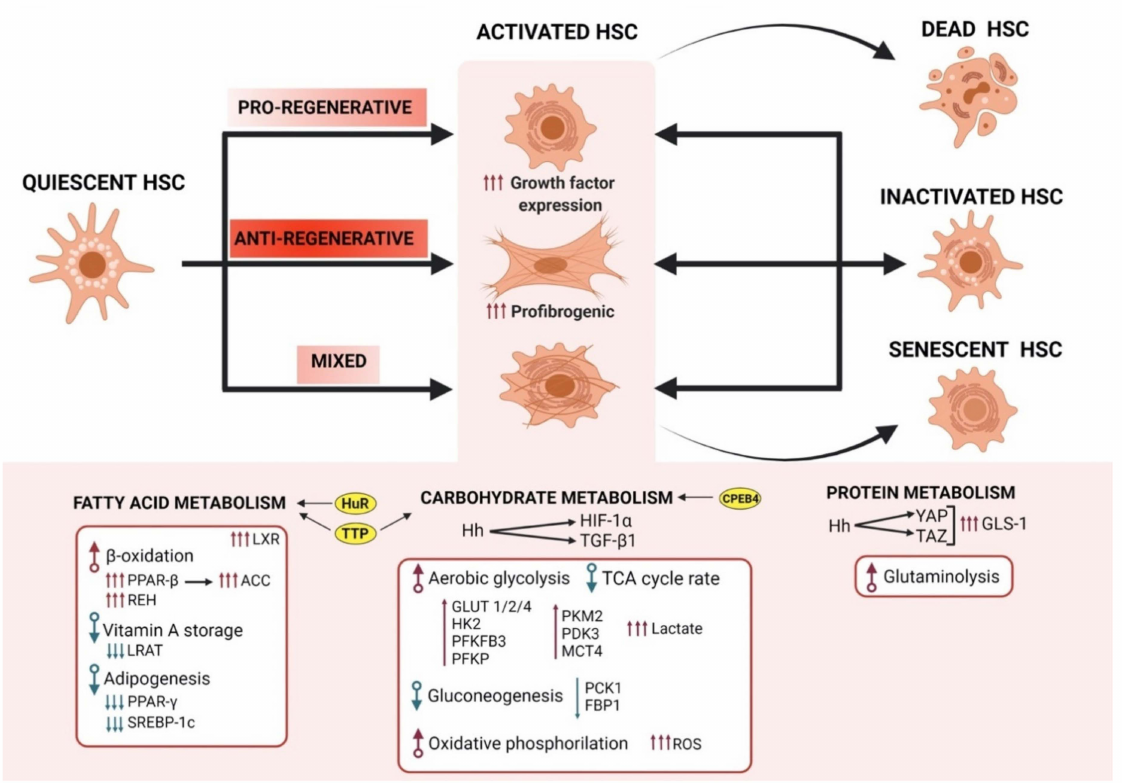
Figure 2. Metabolic reprogramming of HSCs during hepatic fibrosis. HSC activation is accompanied by a sequence of metabolic changes that allow the cell to meet their energetic demands that are required to materialize their newly acquired capabilities. Recent classification has subdivided activated cells depending on their expression profile, being pro-regenerative (increased growing factors), anti-regenerative (high pro-fibrogenic profile), and a subgroup with mixed phenotype. Once activated, genes that are related with retinol catabolism, such as retinyl ester hydrolase (REH), are upregulated, while enzymes that are involved in retinol esterification, such a lecithin retinol acyltransferase (LRAT), are downregulated. Consequently, lipid droplets disappear and they are metabolized to fuel the β -oxidation pathway. Enzymes that are involved in lipid metabolism such as the Liver X Receptors (LXRs) are upregulated and adipogenic regulators such as sterol regulatory element-binding protein 1 (SREBP-1c) are downregulated. Interestingly, the activated HSCs increase also their rate of aerobic glycolysis and the corresponding relevant enzymes while gluconeogenesis enzymes are reduced. Lactate accumulates intracellularly as well as the reactive oxygen species (ROS) and the oxidative phosphorylation pathway, while the tricarboxylic acid (TCA) pathway is downregulated. These metabolic changes are controlled, at least partially, by the activation of the Hedgehog (Hh) pathway via the expression of hypoxia-inducible factor 1-alpha (HIF-1 α ) together with transforming growth factor- β 1 (TGF- β 1). Glutaminolysis and protein metabolism is also upregulated alongside their rate-limiting enzymes, such as glutaminase-1 (GLS-1). This process is also regulated by the Hh pathway, this time via the transcription factor Yes-associated protein 1 (YAP) and its transcriptional cofactor TAZ. Interestingly, RNA-binding proteins (RBPs) such as polyadenylation-element-binding protein 4 (CPEB4), human antigen R (HuR), and tristetraprolin (TTP) have been described as key regulators of these metabolic rewiring in HSCs. Once the liver damage is relieved, the activated HSCs could become inactivated, dead, or senescent followed by their elimination via the immune system. The figure created with